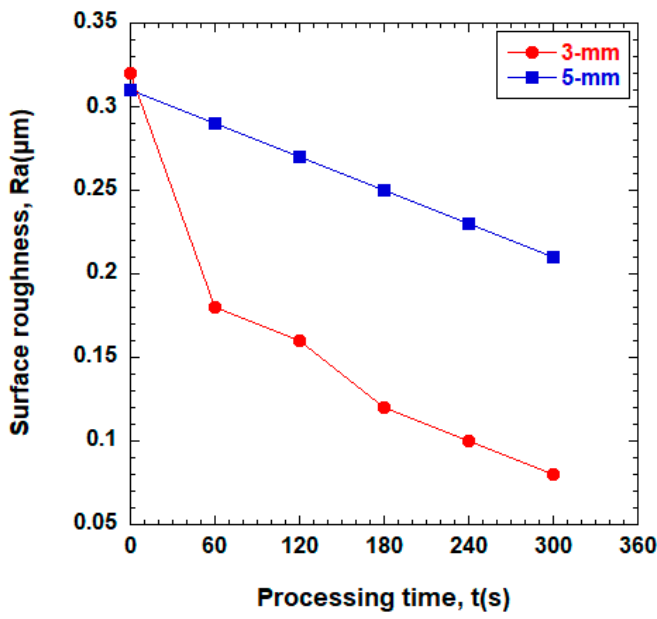
Figure 8. Surface roughness (Ra) vs. processing time for different finishing gaps (vibration: 8 Hz; abrasive: 1 µ m; rotation: 2000 rpm; sharp edge magnetic pole).